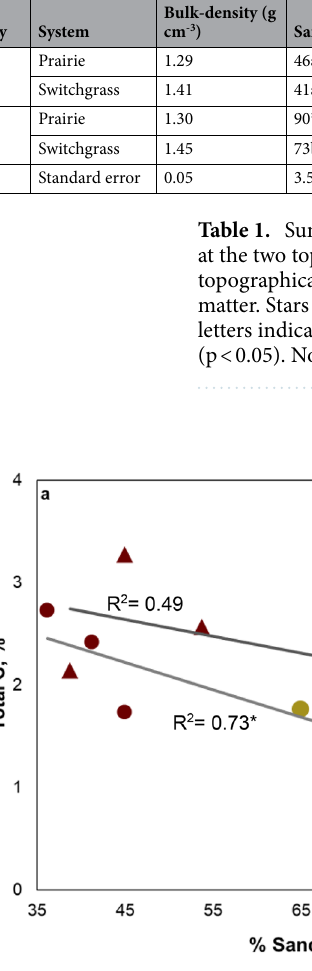
Figure 3. Total soil C ( a ) and N ( b ) plotted vs. sand content across depression (red) and slope (yellow) soils in prairie ( ▲ ) and switchgrass ( ● ) systems. R2 value marked with * are significant at p < 0.05. Total C and N were significantly higher in prairie than in switchgrass (ANCOVA with sand as a covariate, p < 0.05 and p < 0.1 for C and N, respectively).